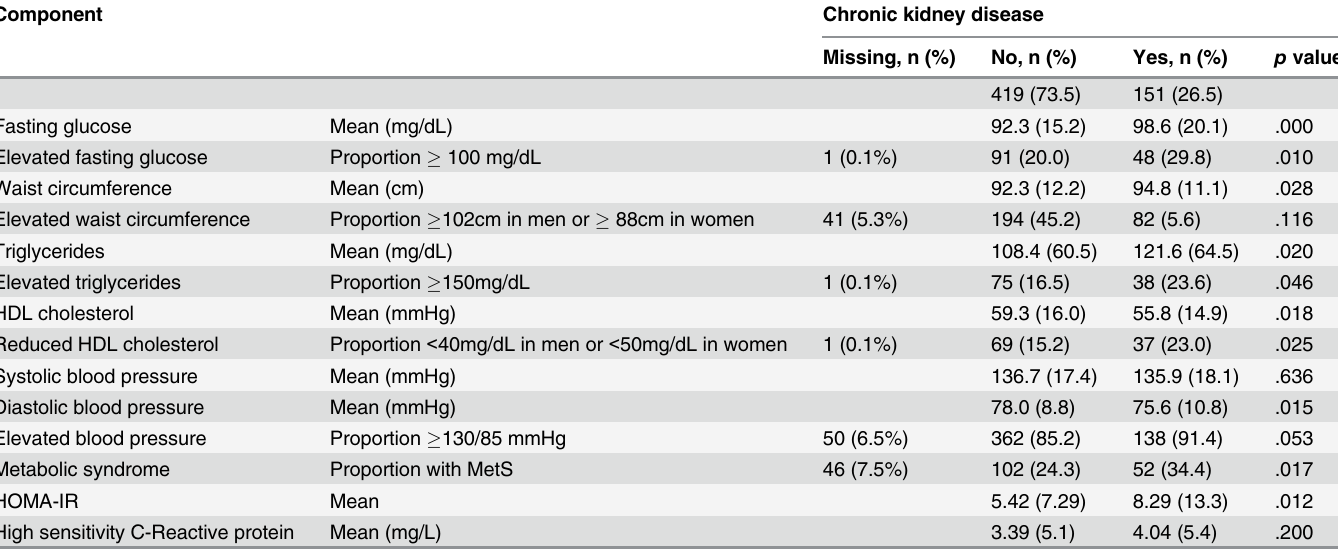
Table 2. Prevalence of individual components of the metabolic syndrome in participants with and without chronic kidney disease.